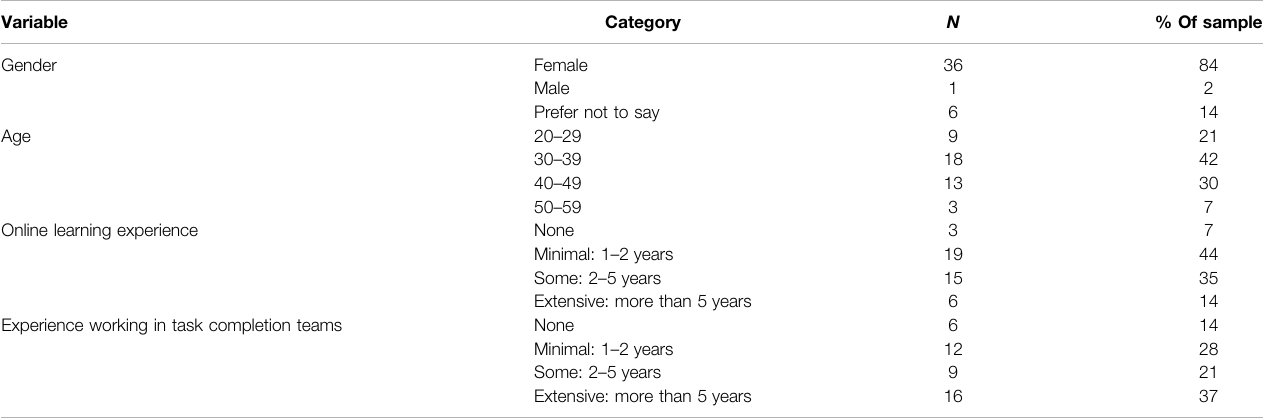
TABLE 1 | Demographic characteristics of